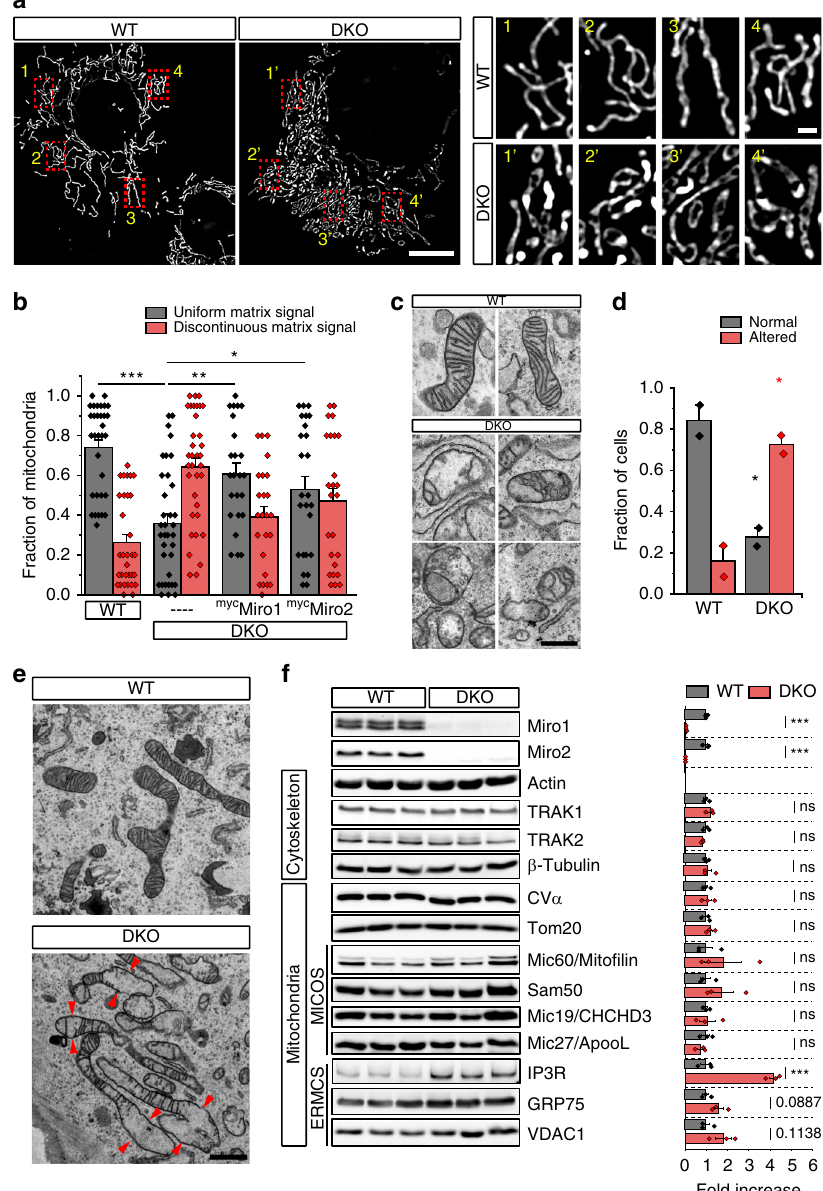
Fig. 1 Loss of Miro is associated with altered cristae morphology. a Imaging of the mitochondrial matrix with mtRo GFP . WT and Miro DKO MEF cells were transfected with the mitochondrial matrix-targeted mtRo GFP and imaged using structured illumination microscopy (SIM) (scale bar: 10 μ m; insets: 1 μ m). b Quanti fi cation of the images shown in ( a ) by scoring abnormalities in matrix continuity revealed by GFP in WT, DKO, and DKO cells re-expressing Miro proteins ( n = cells; in which 32 WT, 35 DKO, 24 DKO re-expressing Miro1 and 25 DKO re-expressing Miro2 cells were assessed, obtained from three independent preparations; One-way ANOVA, Bonferroni post hoc). c TEM images of mitochondrial cristae morphologies observed in WT and Miro DKO MEFs (scale bar: 500 nm). d Quanti fi cation of TEM images after classi fi cation of the cells as having normal cristae morphology or an altered cristae morphology ( n = experiments; in which 54 WT and 51 Miro DKO cells were analyzed from two independent sample preparations; Student ’ s t test with Welch ’ s correction). e Representative EM images of the mitochondria from WT and DKO cells showing the homogeneity of cristae in WT cells and the appearance of spaces and enlargement of mitochondrial units in regions without cristae in DKO cells (scale bar: 1 μ m). f Western blot analysis and quanti fi cation of three different cell lines independently generated for each genotype ( n = independently generated cell lines; three for WT and three for DKO; Student ’ s t test) to analyze cellular levels of proteins related to the cytoskeleton, MICOS complex, and ERMCS. Error bars represent ± SEM. Signi fi cance: * p < 0.05; ** p < 0.01; *** p <